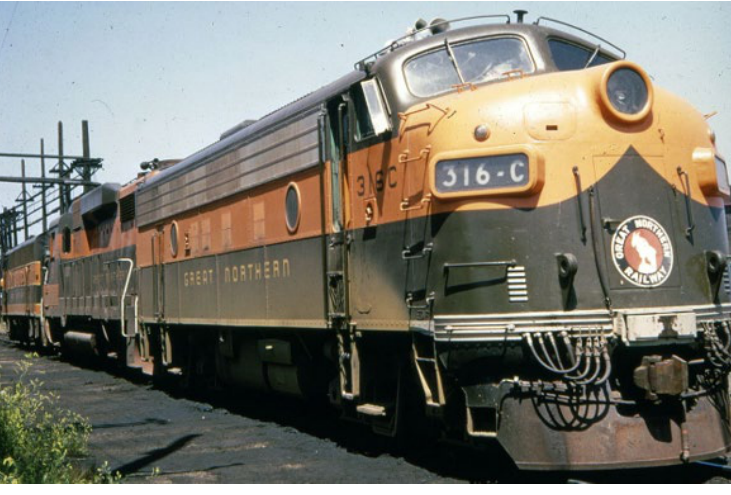
Figure 1. An example of a diesel–electric train (F7A)